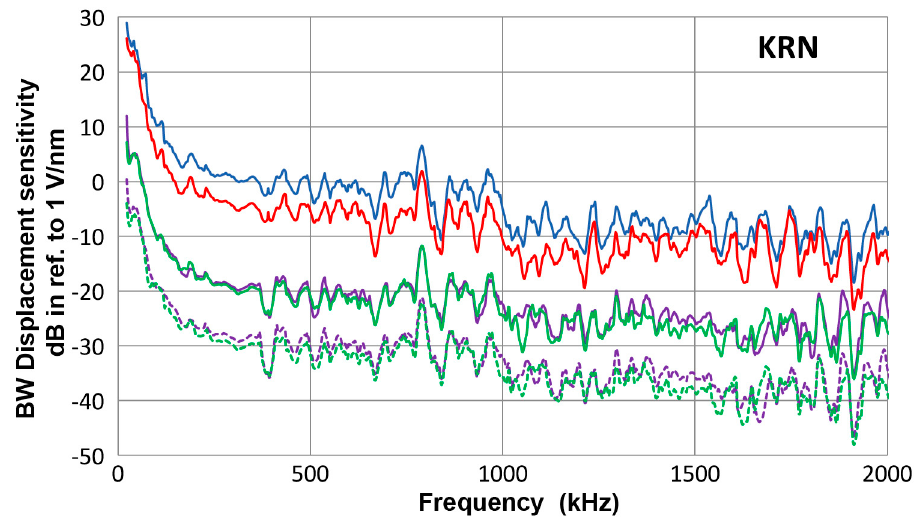
Figure 1. Bar-wave receiving sensitivities of KRN sensors. Blue -#11053, red -#11063, green -#12060, purple -#12035 (solid curves with 10 M Ω and dashed curves with 100 k Ω ).